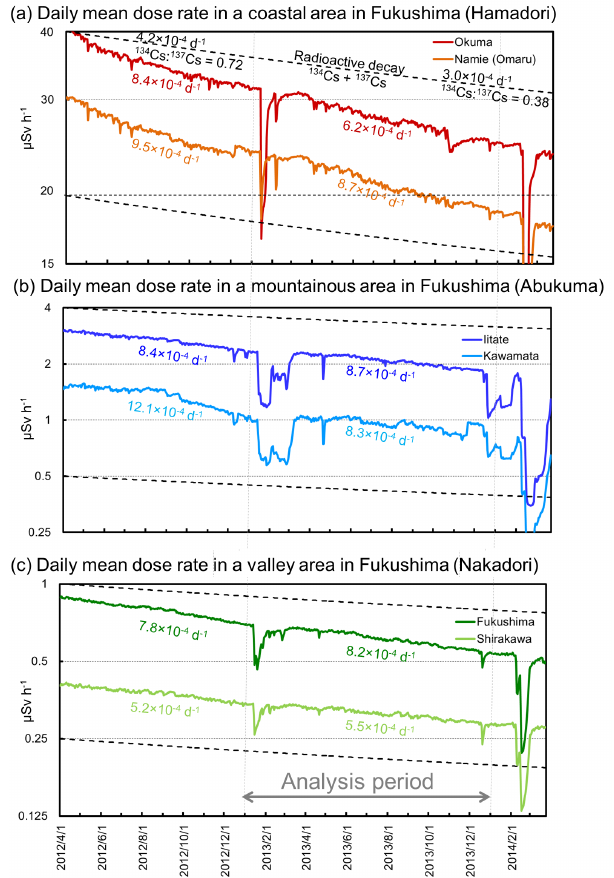
Figure 14. Daily mean gamma dose rate at the six monitoring sites: ( a ; red) Okuma and (orange) Namie (Omaru district) in the coastal area, ( b ; blue) village of Iitate and (sky blue) town of Kawamata in the Abukuma highland area, and ( c ; green) cities of Fukushima and (greenish yellow) Shirakawa in the Nakadori valley area of Fukushima prefecture as presented in Fig. 1b for two fiscal years (from April 2012 to March 2014). The first-order decreasing rates of the least-squares approximation over the period of no snow cover (May to October, 2012 and 2013) is also presented, along with the radioactive decay ( 134 Cs plus 137 Cs, by assuming the same amount of activity on 12 March 2011) in April 2012 and March